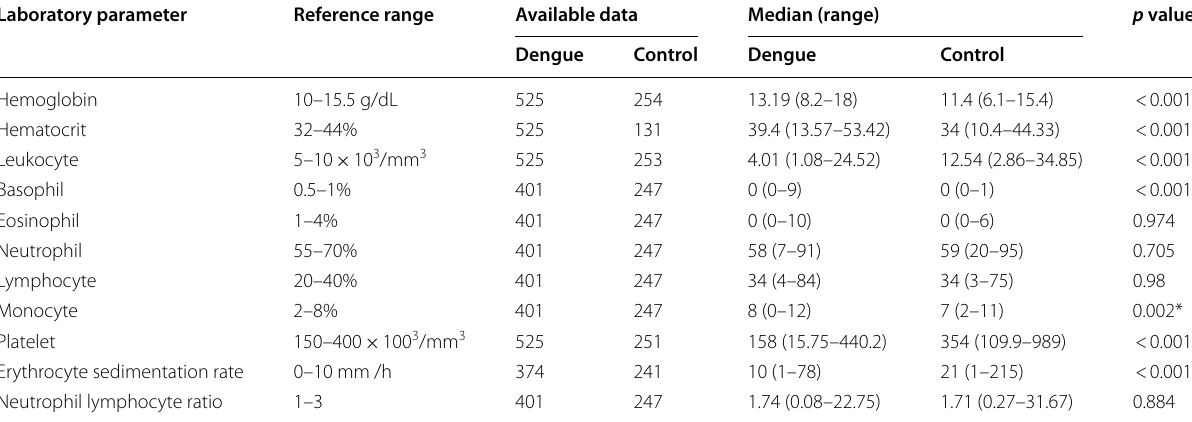
Table 3 Numerical comparison of laboratory parameters of dengue and control